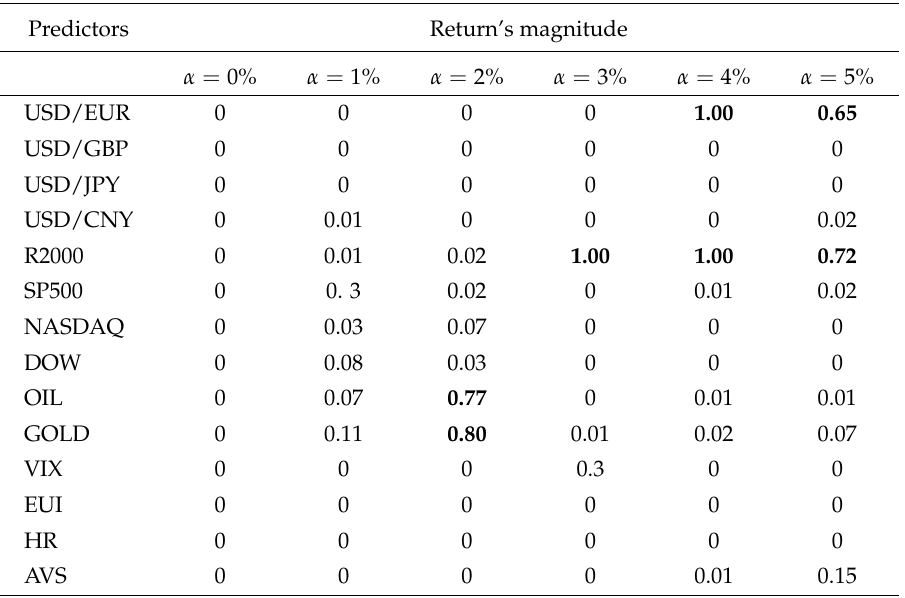
Table 4. Posterior probabilities of inclusion of the explanatory variables for the binary BTC series for the period ranging from 1/2016 to 11/2019 The probabilities of the variables that are included in the median probability model, i.e., the variables with probability of inclusion above 0.5, are highlighted with